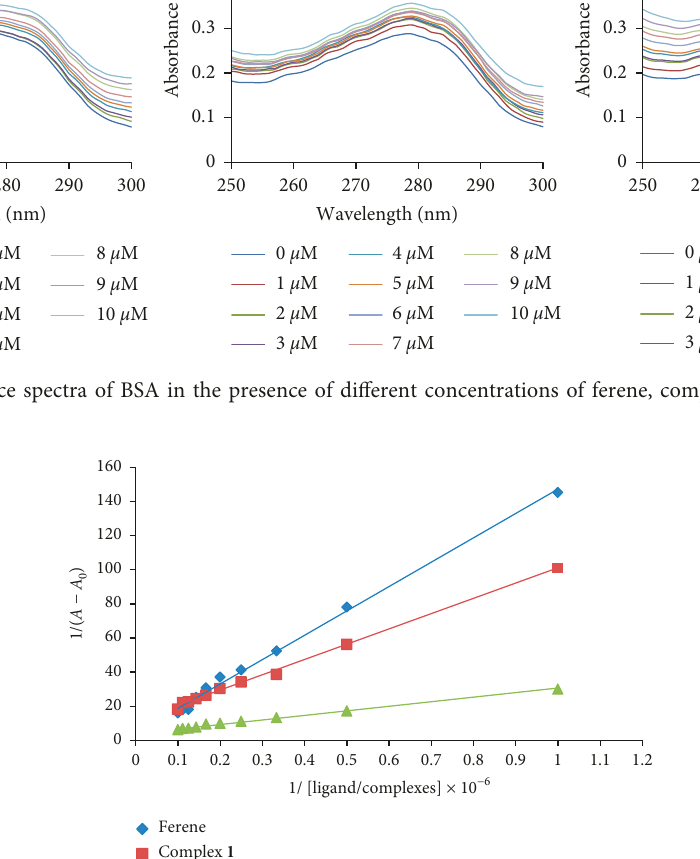
A 0 ) versus 1/[ligand/complexes] for ferene ligand ( R 2 −